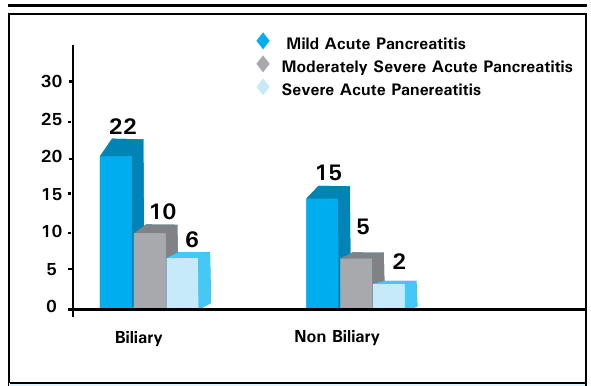
Figure 2. Distribution of severity of pancreatitis.